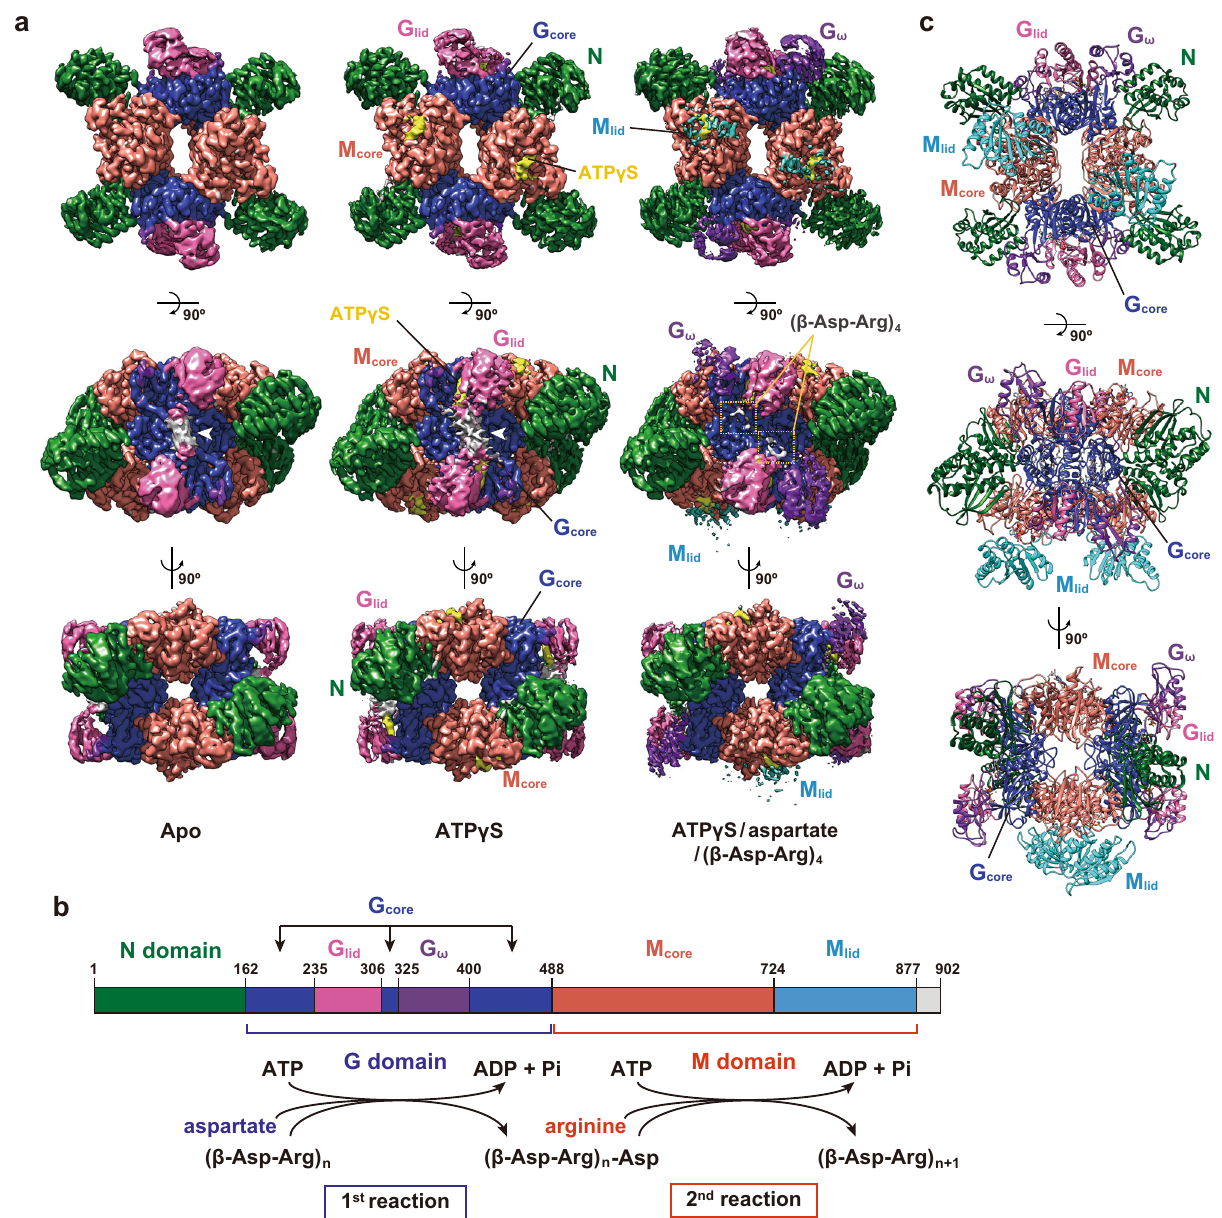
Fig. 1 | Tetrameric structure and domain architecture of Te CphA1. a Cryo-EM maps of Te CphA1 in the apo, ATP γ S-bound, and substrate (ATP γ S/aspartate/( β -Asp- Arg) 4 )-boundstates.Themapsare divided intosixmodules(N, G core ,G lid ,G ω ,M core , and M lid ) and ATP γ S, which are shown in different color coordination. The map of ( β -Asp-Arg) 4 is highlighted with a yellow dashed-line box in the density map of substrate-bound Te CphA1. A lump on the extra map (arrowhead) is observed